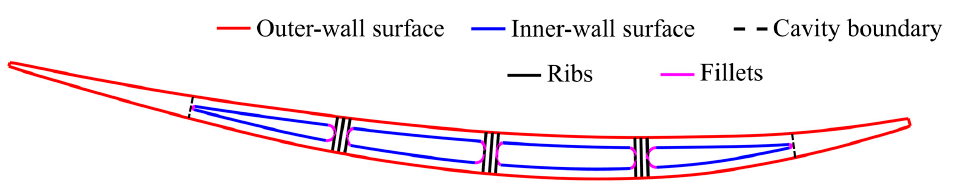
Figure 3. Structural frame of the hollow section.